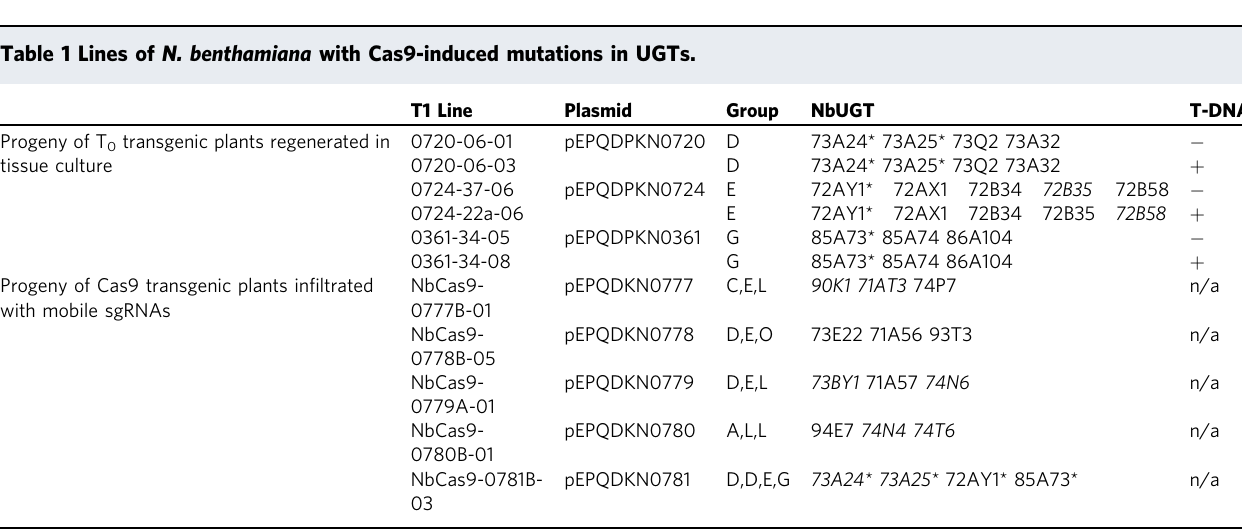
(Table 1, Supplementary Fig. 5 and Supplementary Table 3). These vectors were in fi ltrated into transgenic plants constitutively expressing Cas9. Progeny seeds (designated as E 1 ) were collected from pods that formed on stems in which mutations were detected at the target sites (see methods). The genotypes of E 1 plants were analyzed, again selecting lines with homozygous, heterozygous or biallelic mutations at target locations. Overall, the mobile sgRNA method was less ef fi cient, with eight out of fi fteen mobile sgRNAs introducing mutations at their target. This resulted in the selection of fi ve E 1 lines, each with mutations in one, two or three target UGTs (Table 1 and Supplementary Fig. 5). As above, there were no changes in growth or development.